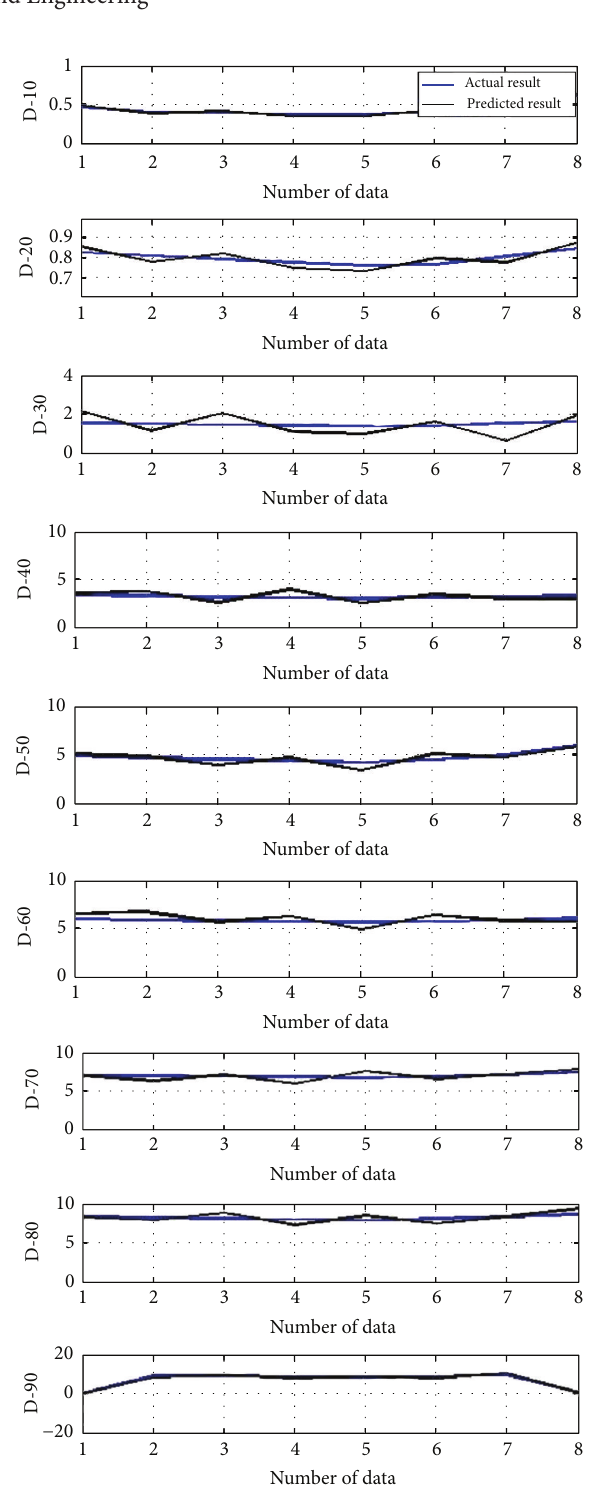
Figure 11: Prediction of load versus